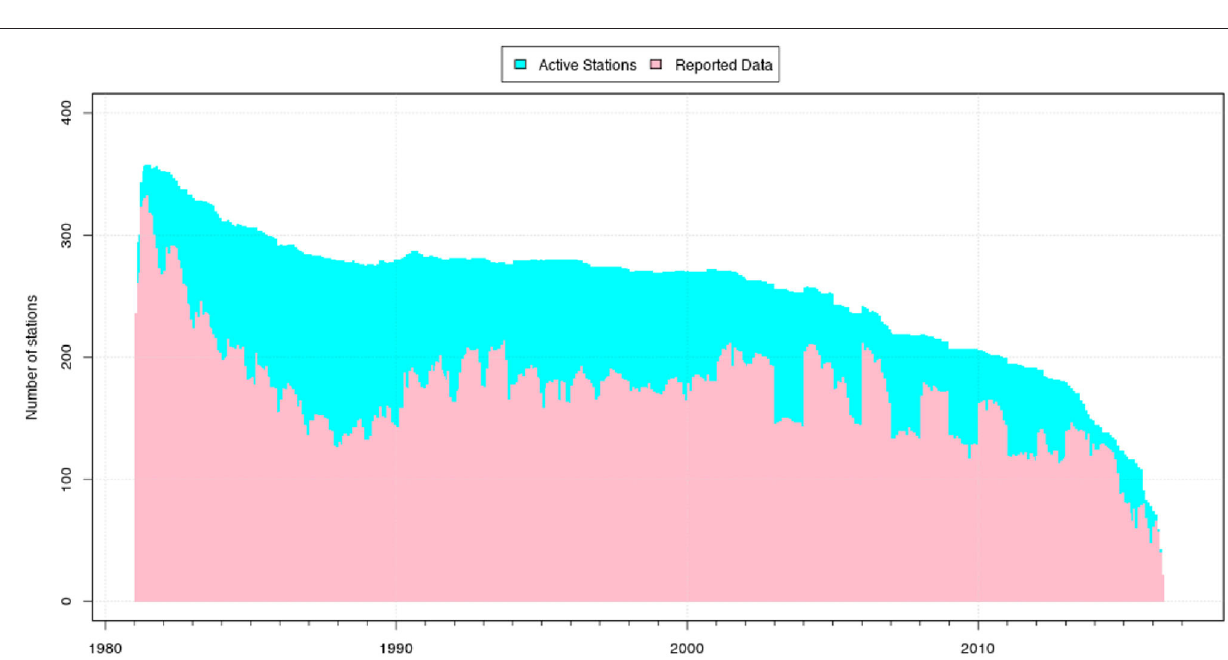
FIGURE 6 | Active stations and reported data from the same